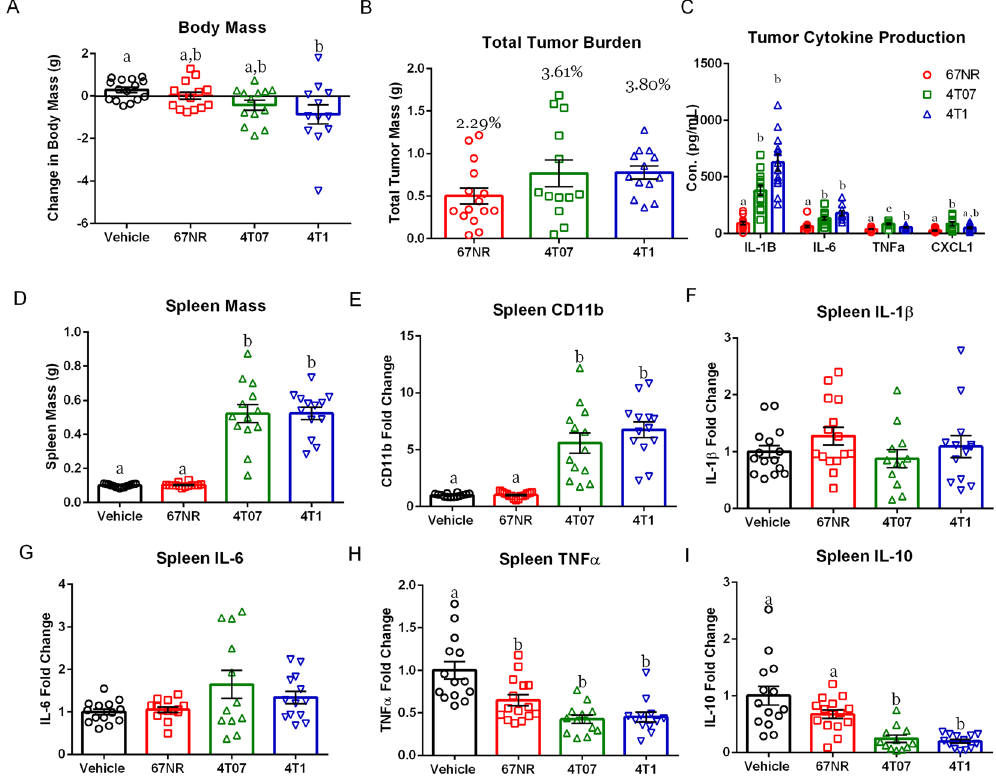
Figure 1. The Effects of Mammary Tumors on Body Mass and the Peripheral Cytokine Response Are Cell Line Specific. ( A ) Change in body mass between date of tumor inoculation (DOI) and date of euthanasia (DOE) accounting for tumor mass (TTB) for vehicle and each cell line ((DOE-DOI)-TTB); only mice with 4T1 tumors had significant body mass loss relative to the vehicle controls. ( B ) Total tumor burden in grams, and as a percentage of body mass, did not differ between cell lines. ( C ) Protein cytokine concentrations of IL-1 β , IL-6, and TNF- α were elevated in 4T07 and 4T1 tumors relative to 67NR tumors. CXCL1 was elevated in 4T07 tumors relative to 67NR and 4T1 tumors. ( D ) Spleen mass was elevated among mice with 4T07 and 4T1 tumors relative to 67NR tumors and vehicle treated mice. ( E – I ) Spleen mRNA expression expressed as fold change from vehicles. ( E ) Macrophage marker CD11b was elevated in 4T07 and 4T1 tumors relative to vehicles and 67NR tumors. ( F and G ) Spleen IL-1 β and IL-6 mRNA did not differ between groups. ( H ) TNF α mRNA expression was significantly reduced in all cell lines relative to vehicles.( I ) IL-10 expression was significantly reduced in 4T07 and 4T1 tumors relative to 67NR tumors and vehicles. The measures and tissues were collected 20 days after tumor cell or vehicle inoculation (n = 12–15/group). The data are presented as mean + SEM. Graph bars that do not share a letter are statistically significant different at p <